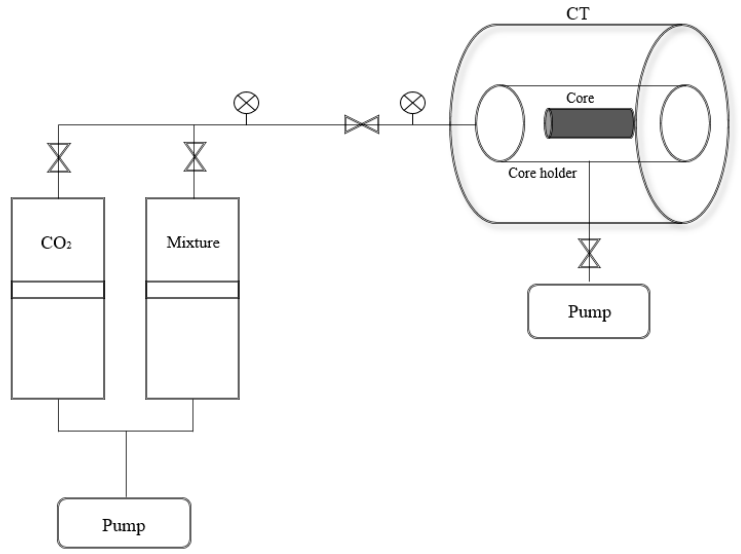
Figure 5. Schematic of CO 2 huff-n-puff.